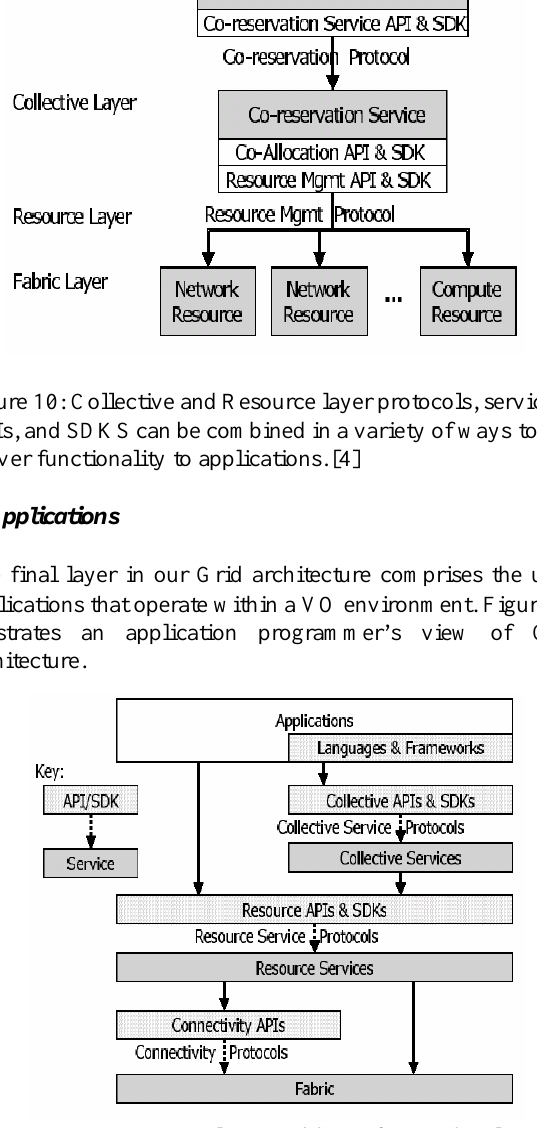
Figure 11: APIs are implemented by software development kits (SDKs), which in turn use Grid protocols to interact with network services that provide capabilities to the end user. [9]